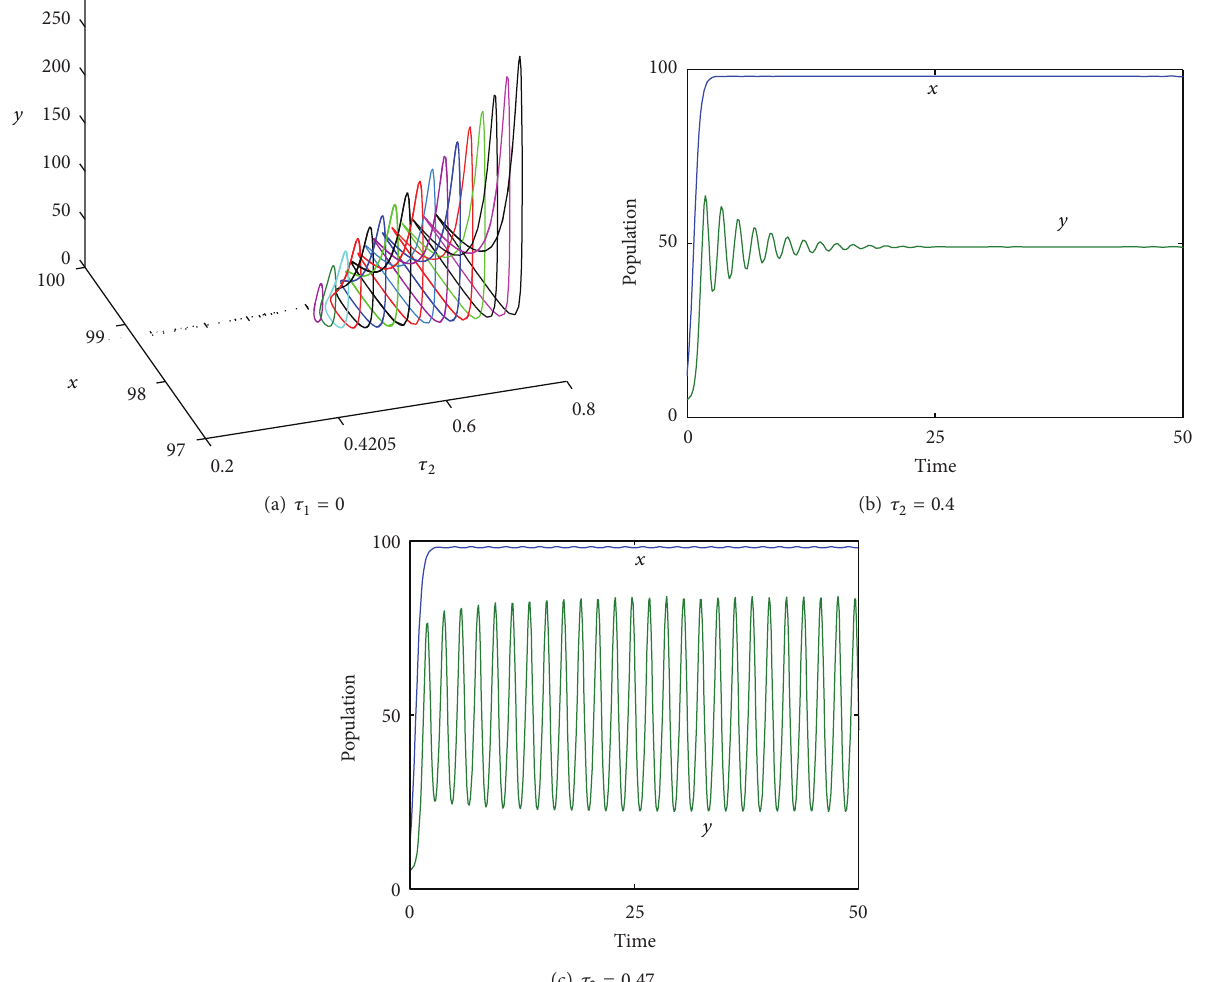
Figure 4: Bifurcation diagrams of the system (3) with respect to 𝜏 2 in Case 4 in the three-dimensional space (𝜏 2 ,𝑥,𝑦) . (b) is the time series ) and (c) is the same for (𝜏 for (𝜏 2 < 𝜏 2 0 > 0.4205 , and a Hopf bifurcation exists at 𝜏 𝜏 2